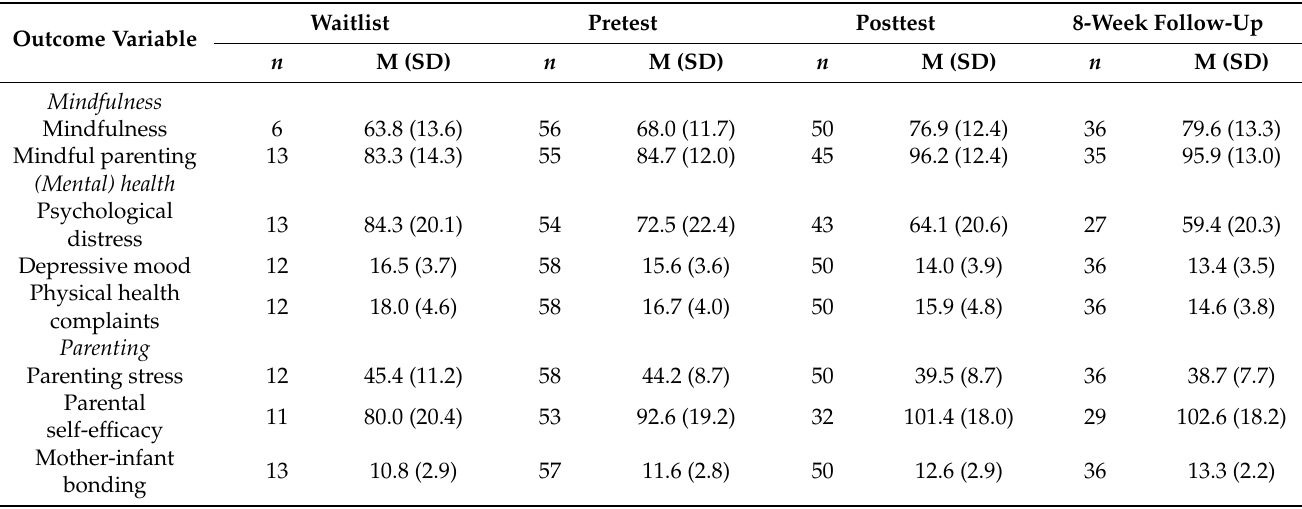
Table 3. Means and standard deviations of all dependent measures at all measurement occasions, the Mindful with Your Baby training took place between pretest and posttest.